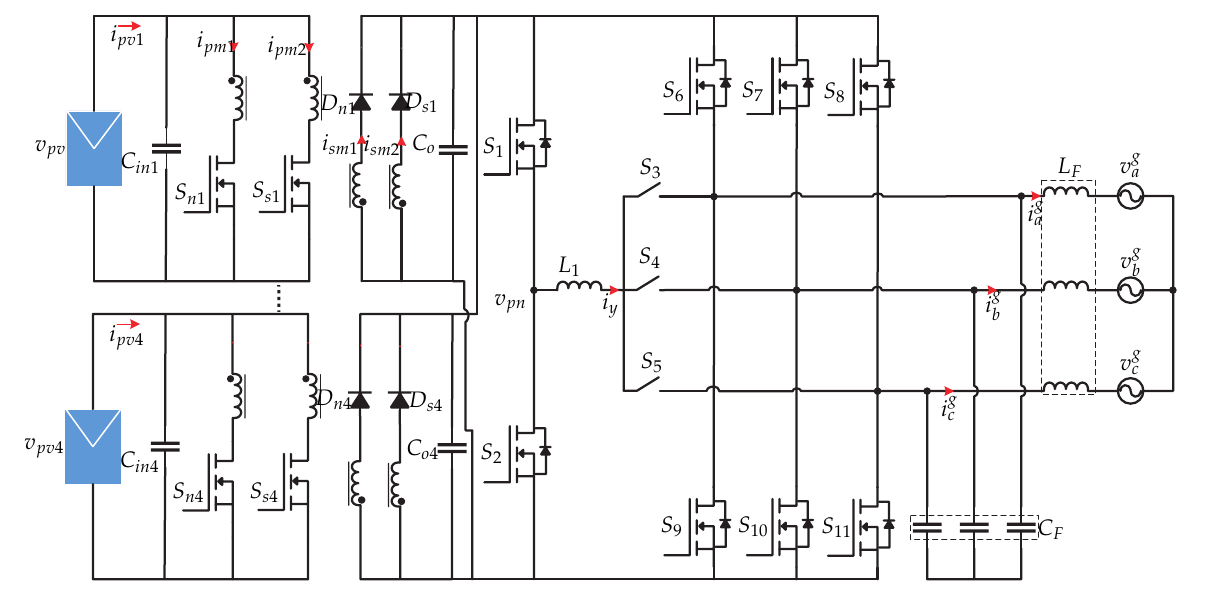
Figure 30. Microinverter’s topology proposed in [66].